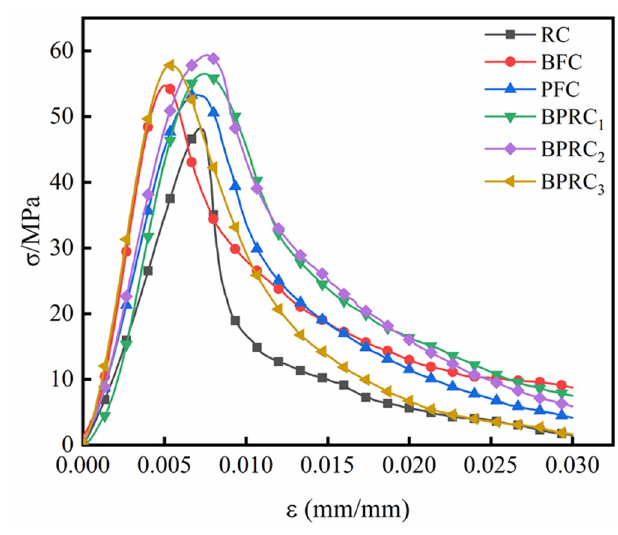
Figure 4. Uniaxial compression stress-strain